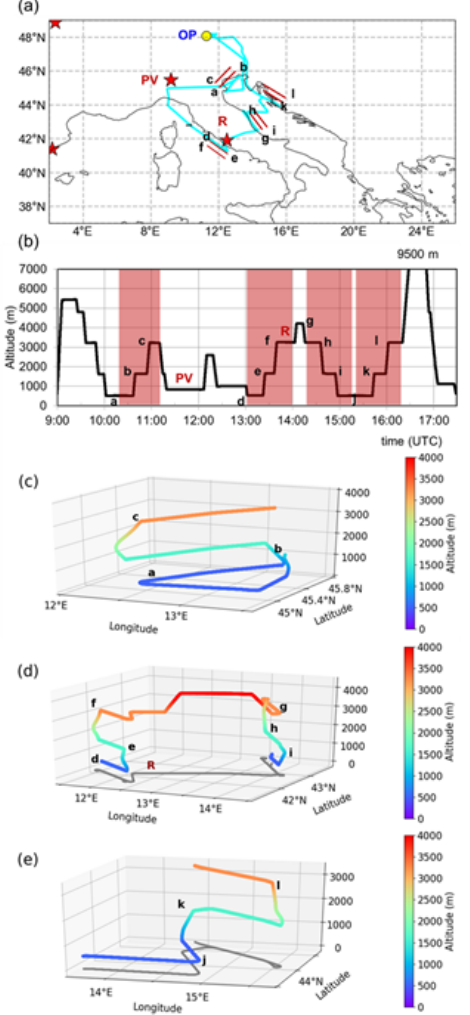
Figure 6. Details of the E-EU-06 flight on the 20 July 2017. Three shuttles took place downwind of the Po Valley (PV), upwind of Rome (R) and along the Adriatic coast and are marked with red lines on the map in panel (a) , as red-shaded areas on the altitude di- agram in panel (b) , and as a 3-D depiction in panels (c) , (d) , and e ). The flight tracks during the shuttles d and e are shown in grey. The flight track in panel (a) is coloured as in Fig. 4, and the EMeRGe MPC targets are in red. Main changes in course and altitude are marked as a–l on the graphs for reference. OP indicates the position of the HALO base.